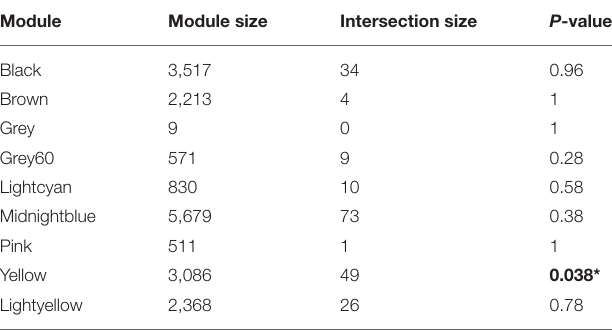
TABLE 2 | The overlap between modules and known epilepsy-related genes.